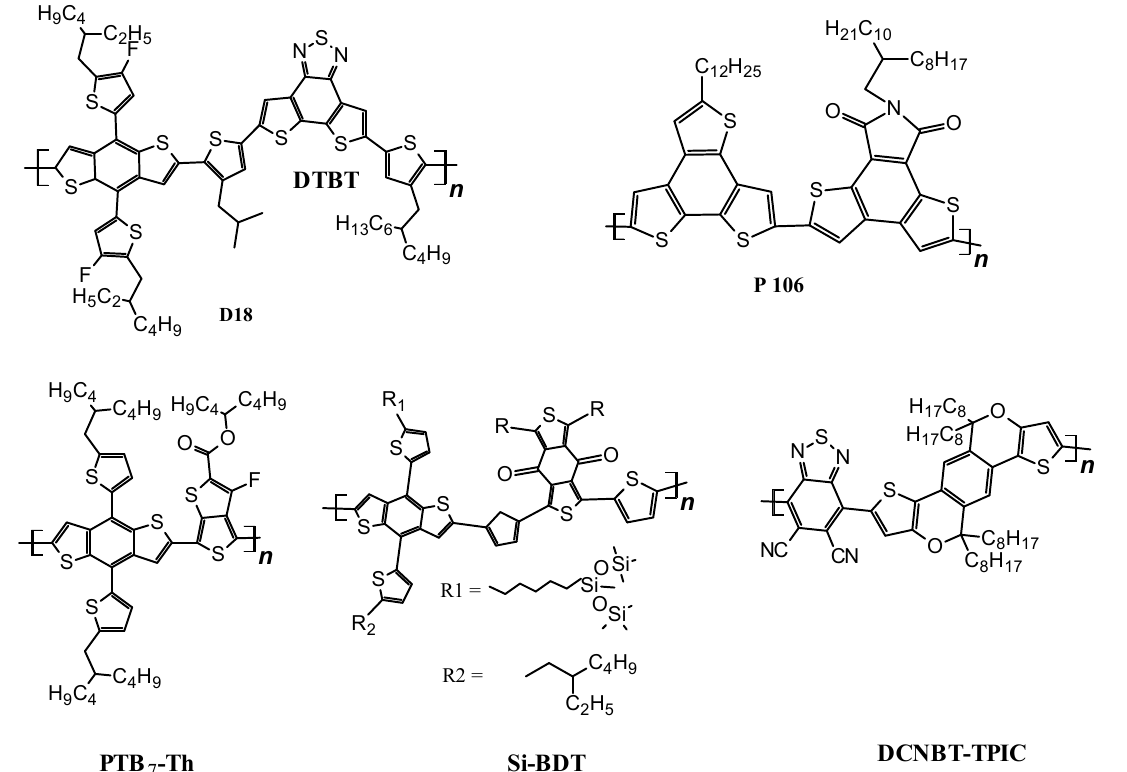
Figure 3. Chemical structures of wide bandgap polymers used in BHJ solar cells. In a separate attempt, Jianqiang et al. fabricated a thick active layer of BHJ solar cells by adding PCBM into a D18-Y6 blend and used the architecture ITO/PEDOT:PSS/ D18:Y6:PC61BM/PDIN/Ag. Increasing the thickness to 110 nm, they achieved a power conversion efficiency of 17.89% [124]. Advancing further, Zhao et al. reported bithieno[3,4- c]pyrrole-4,6-dione (PBiTPD), a donor based on the thieno[3,4-c]pyrrole-4,6-dione (TPD) motif. Using the solar cell structure ITO/PEDOT:PSS/PBiTPD:Y6/PFN-Br/Ag, the power conversion efficiency was 14.2% [125]. Keshtov et al. fabricated the binary and ternary BHJ solar cells by employing a D-A polymer P106 as a donor and two non-fluorine acceptors, Y18-DMO and DBTBT-IC. P106 contained 2-dodecylbenzo[1,2-b:3,4-b (cid:48) :6,5-b (cid:48)(cid:48) ]trithiophene (3TB) as a donor unit with dithieno [2,3-e;3 (cid:48) 2 (cid:48) -g]isoindole-7,9 (8H) (DTID) as an acceptor unit. Two binary solar cells having the architectures of ITO/PEDOT:PSS/P106:DBTBT- IC/PFN/Al and ITO/PEDOT:PSS/P106:Y18-DMO/PFN/Al produced power conver- the structure ITO/PEDOT:PSS/P106: DBTBT-IC:Y18-DMO/PFN/Al obtained a